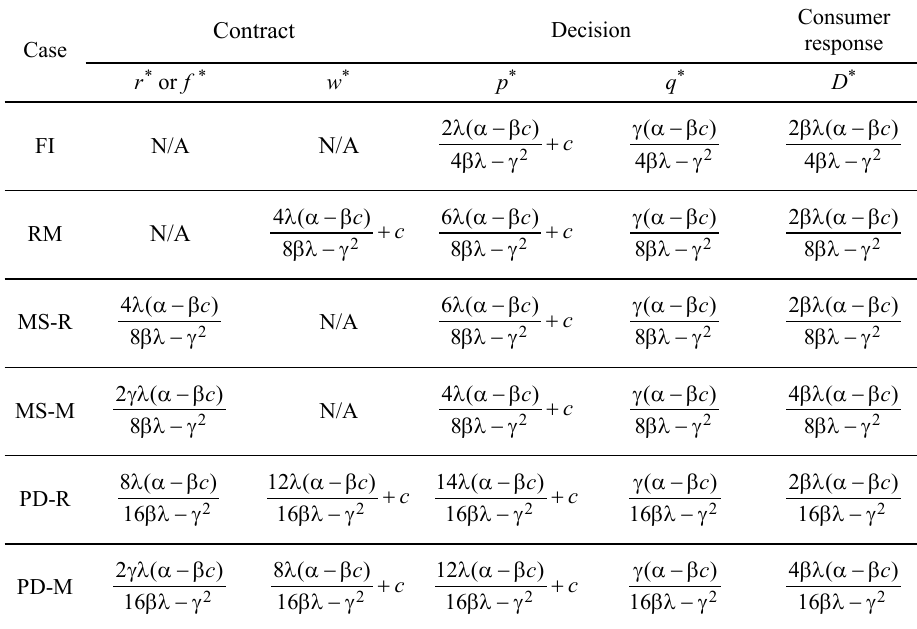
Table 1. Solution summary: